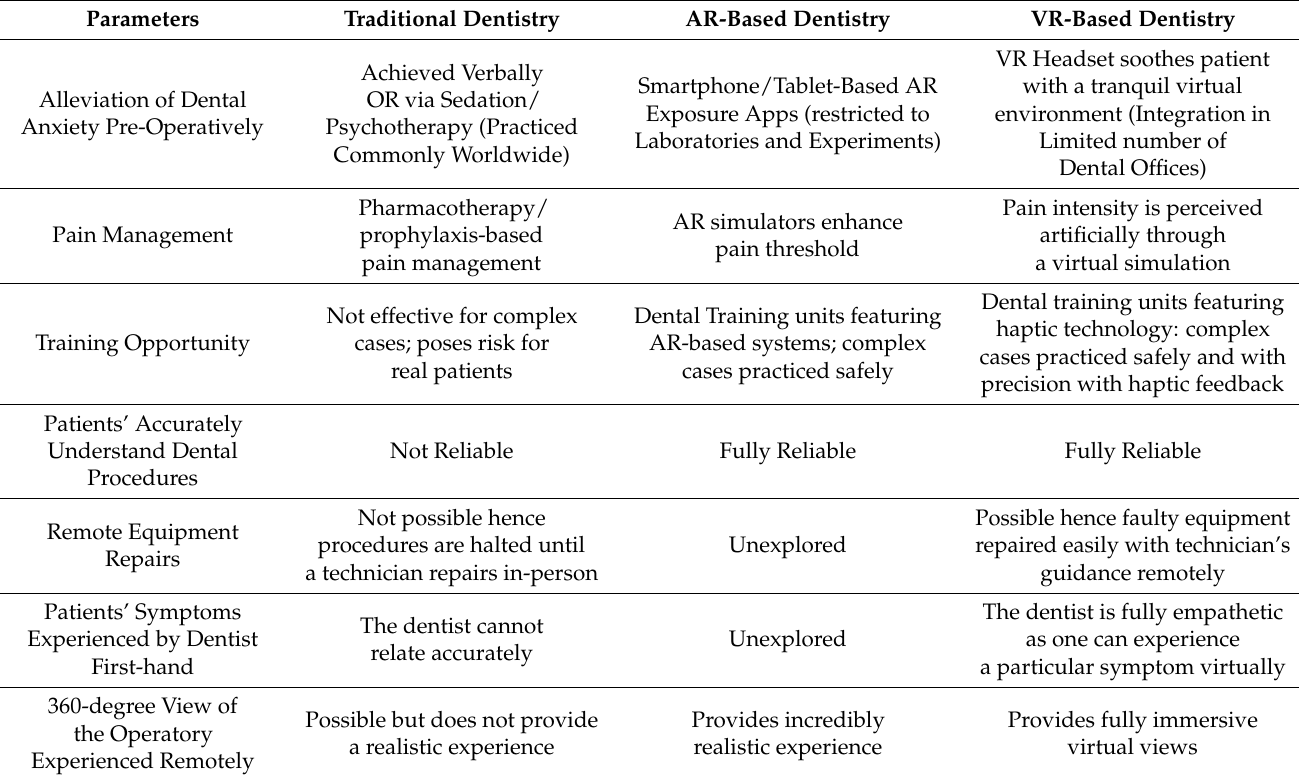
Table 2. Comparison of the benefits offered in AR/VR-based dentistry and traditional